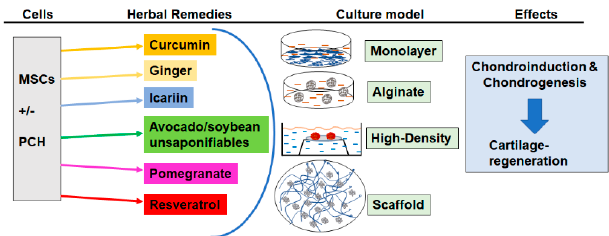
Figure 2. Schematic presentation of the application of plant phytochemicals in cartilage-TE.